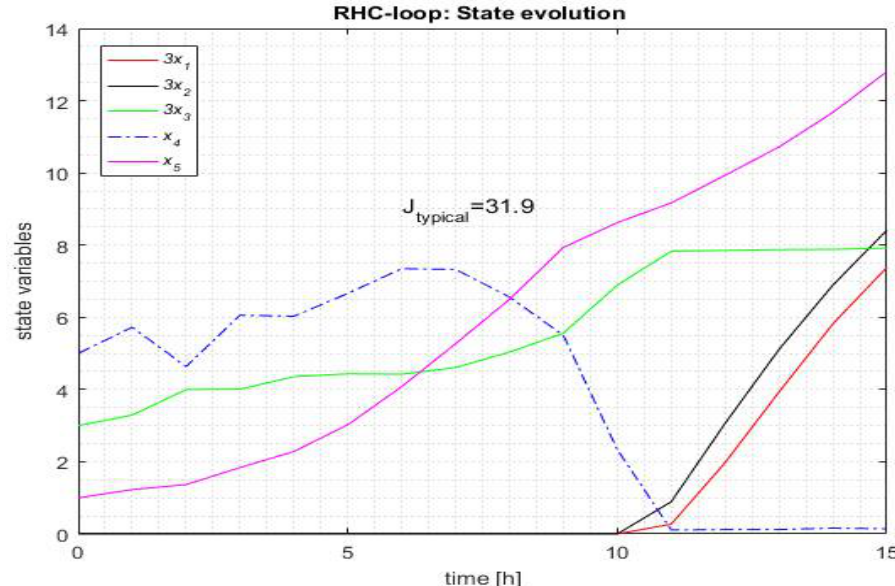
Figure 5. Typical state evolution—controller without control input range estimation. The computational complexity of the first sampling period is the largest because the prediction horizon has H sampling periods. Despite the sequence *(0) u having an H